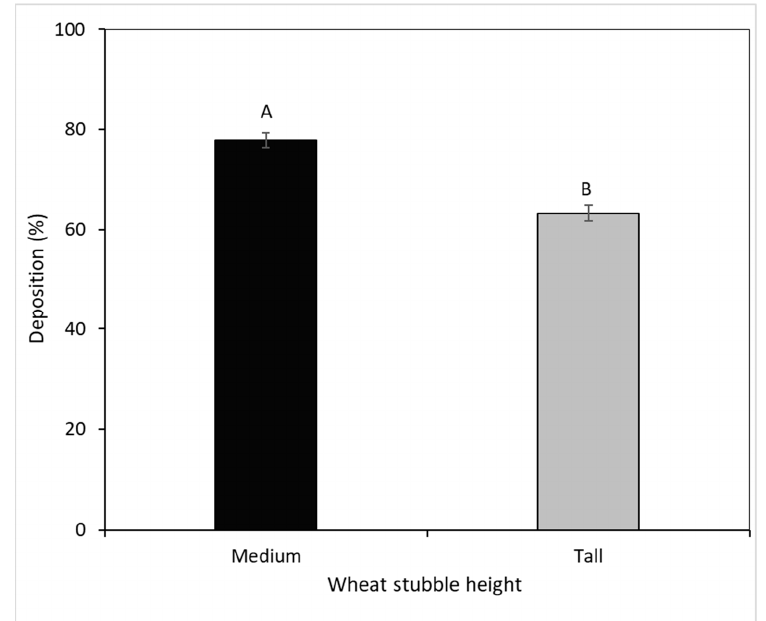
Figure 2. Herbicide spray deposition near the soil surface in tall wheat stubble (greater than 70 cm) and medium stubble (30 – 35 cm). Letters indicate significant differences ( α = 0.05) using Tukey’s medium stubble (30–35 cm). Letters indicate significant di ff erences ( α = 0.05) using Tukey’s studentized studentized range test. range